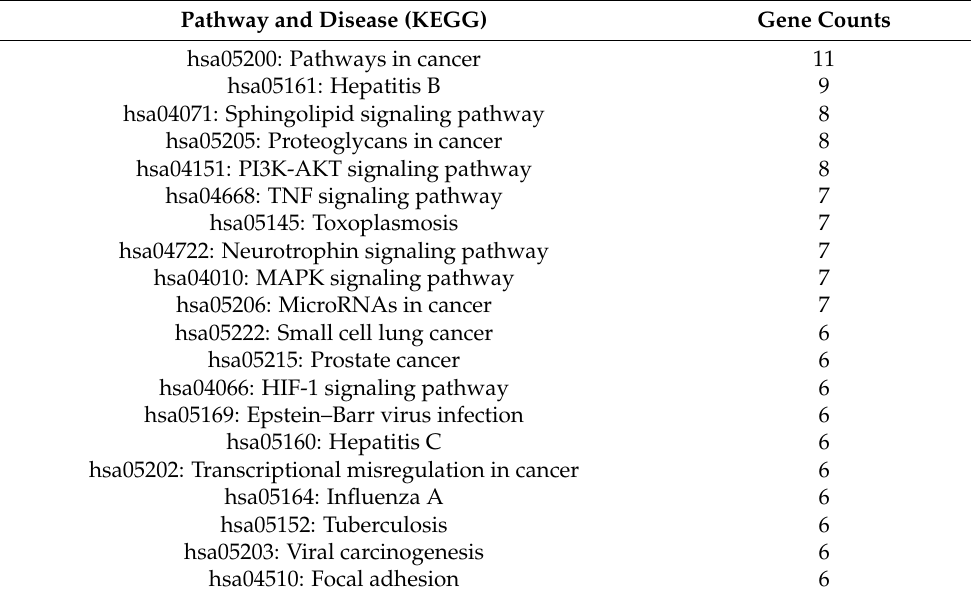
Table 1. Top 20 enriched KEGG pathways and diseases.